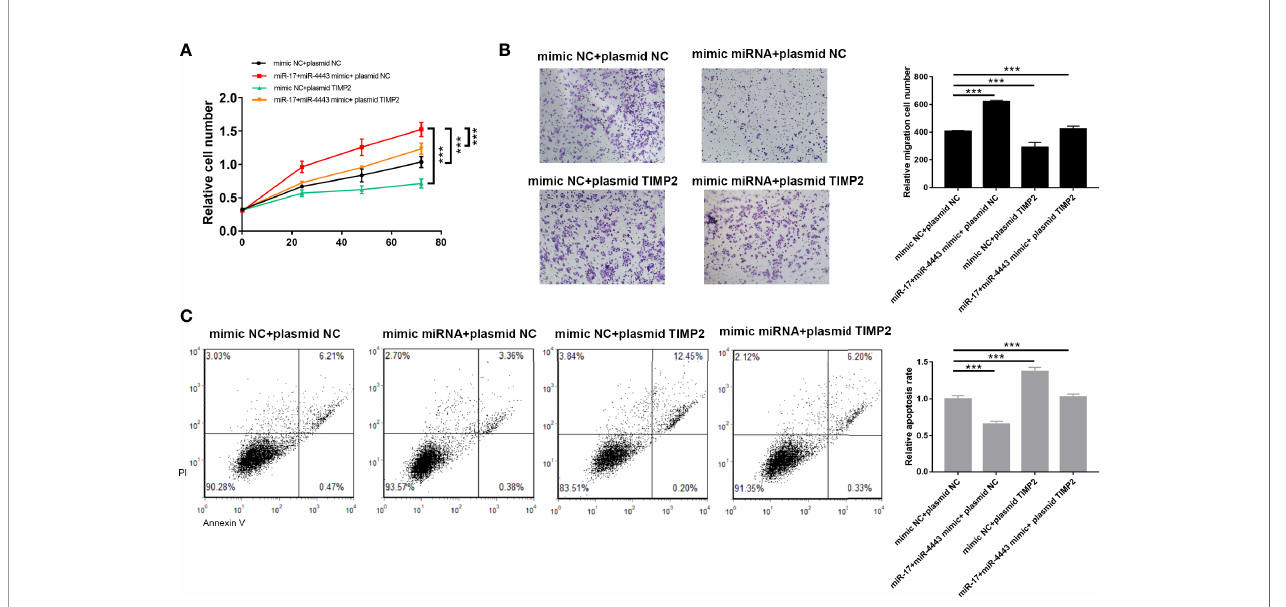
FIGURE 4 | TIMP2 attenuates the effects of the miR-17-5p and miR-4443 in ESCC cells. (A) Analysis of proliferation (A) , migration (B) and apoptosis (C) in TE-10 cells treated with mimic-control plus plasmid control, mimic-miR-17-5p and mimic-miR-4443 mixture plus control vector, mimic-control plus TIMP2 plasmid, or mimic-miR-17-5p and mimic-miR-4443 mixture plus HIC1 TIMP2 plasmid. All results were shown as mean ± SD (n = 3). ***P <